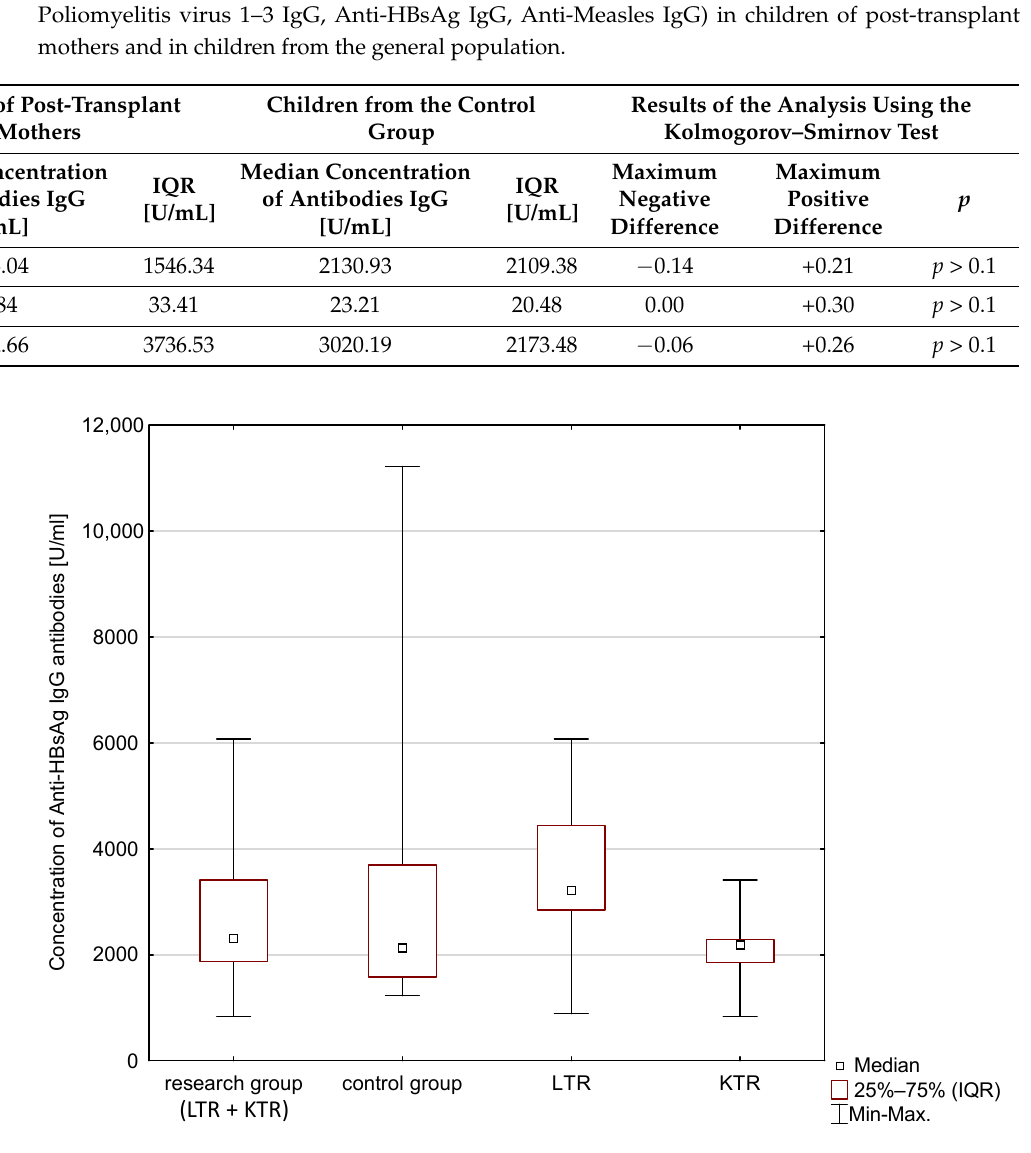
Figure 1. Concentration of Anti-HBsAg IgG antibodies in blood